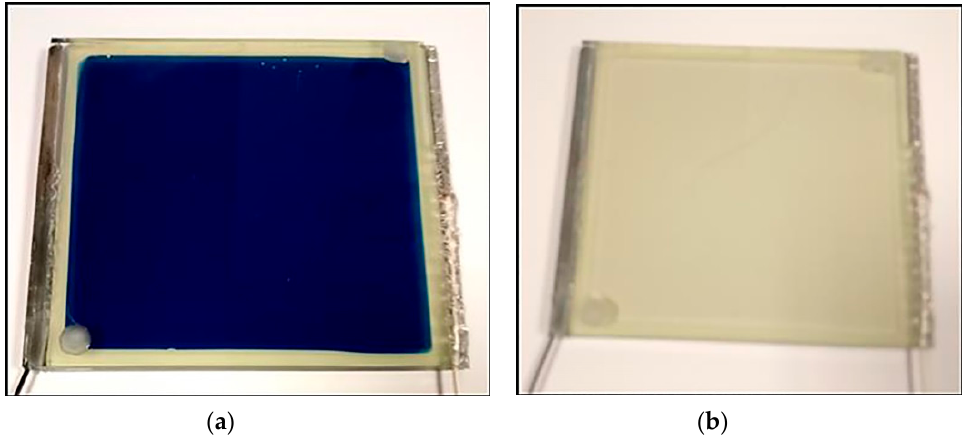
Figure 9. ( a ) Tinted and ( b ) bleached state of the fabricated electrochromic device with dimensions: 9 cm × 10 cm.